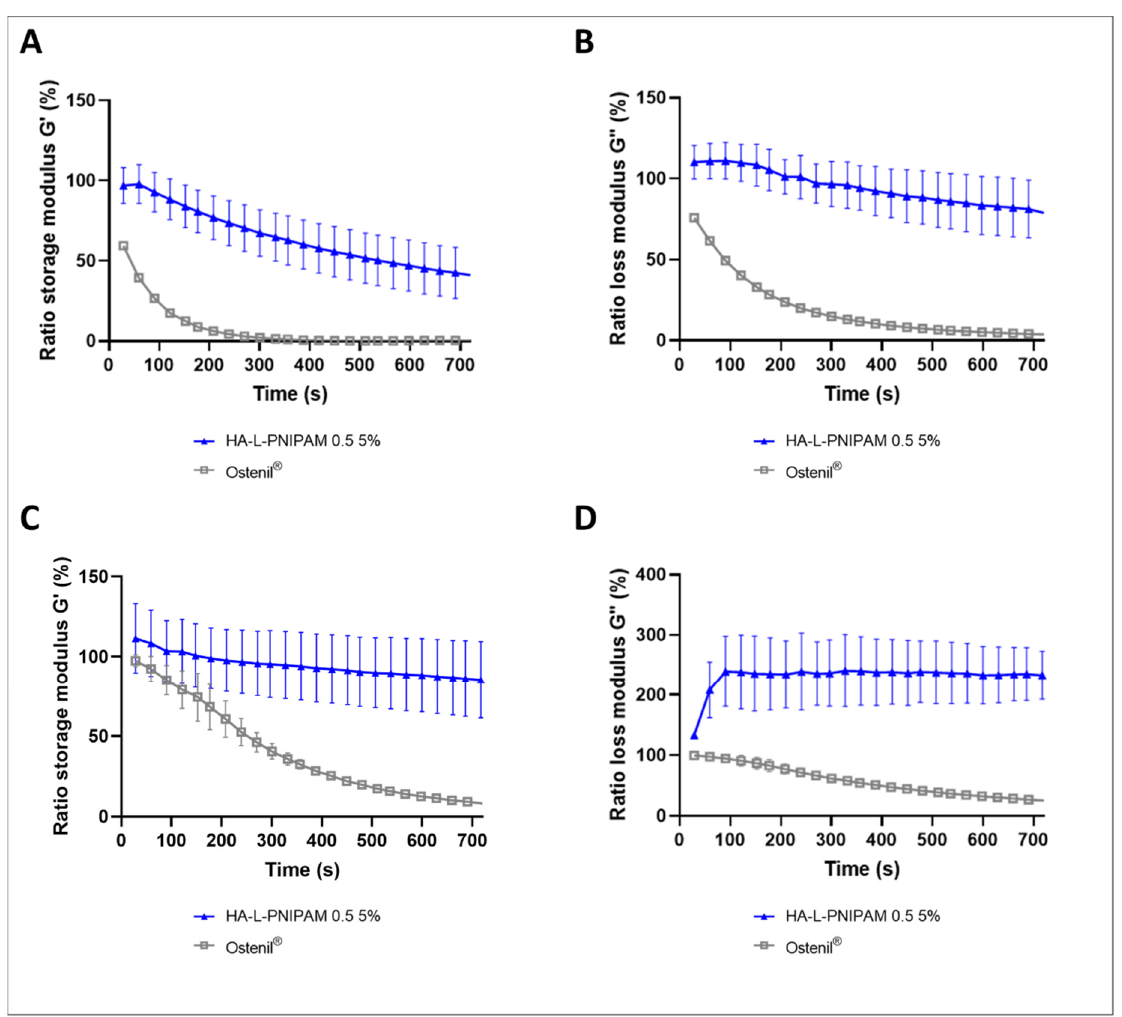
Figure 4. Ostenil ® and HA-L-PNIPAM 0.5 5% storage modulus (G ′ ) and loss modulus (G ″ ), normalized to initial values, as function of time at 0.5 Hz and 37 °C, after addition of 40 µL of hyaluronidase (100 U/mL) ( A , B ) ( n = 3; ± sd). After an addition of 40 µL H 2 O 2 (30% w/w ) ( C , D ) ( n = 3; ±sd). As a control condition, 40 µL of PBS buffer were added to 400 µL of the sample, ratio was made at each timepoint. Table 2. Summary of HA-L-PNIPAM 0.5 5% contents calculated according to values obtained in 1 H NMR spectroscopy.